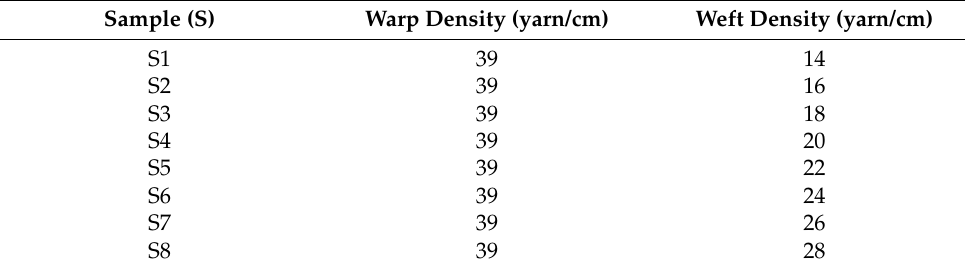
Table 1. The warp and weft density of eight woven fabric samples. Sample (S) Warp Density (yarn/cm) Weft Density (yarn/cm)